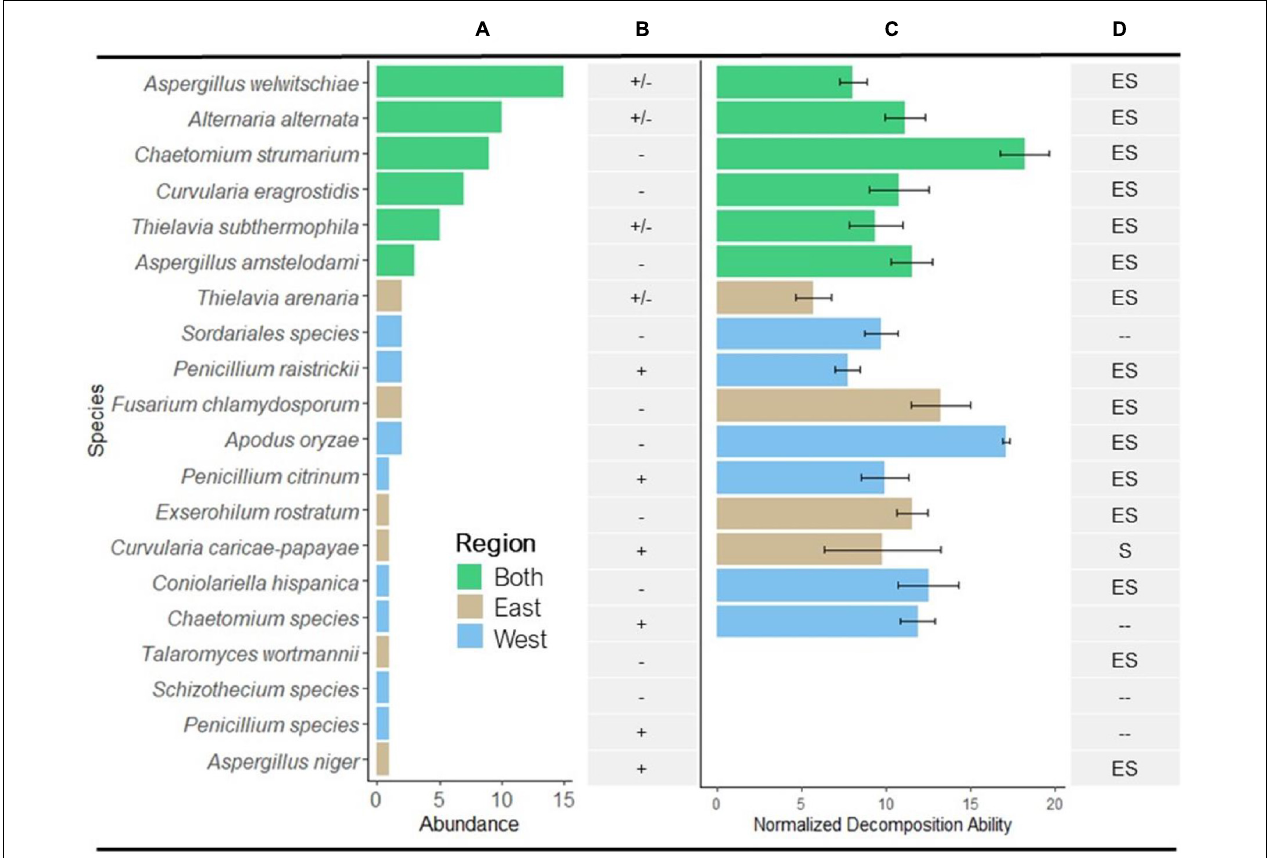
FIGURE 2 | Abundance and decomposition ability of isolated fungi. (A) Distribution of the 20 identified species from eastern and western regions of the Namib Sand Sea (see Table 1 for number of isolates/species). Bar colors correspond to geographical regions. (B) Presence or absence of lignin-degrading enzymes laccase and peroxidase; (+), enzyme presence in all isolates; (–), no enzyme present; ( ± ), enzyme present in some isolates and not present in others. (C) Mean normalized decomposition ability (NDA; mean % mass loss) of isolates that were able to decompose sterile S. sabulicola tillers over 28 days in the Namib diel cycle. Values were normalized relative to mass loss in un-inoculated tillers (Isolate sample size as in A, error bars = 1 × SE; n = 10 for each isolate). (D) Summary of known nutritional modes of endophytic species isolated from S. sabulicola : E, endophyte; S, saprophyte; –, no data as taxa was not identified to species (see Table 1 for